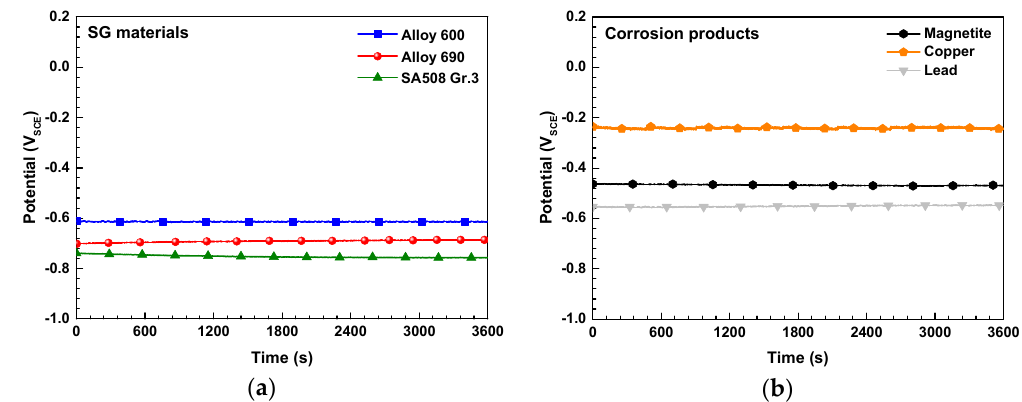
Figure 6. Corrosion potentials of the SG materials and the corrosion products constituting the SG flakes in alkaline solution at 80 °C: ( a ) the SG materials and ( b ) the corrosion products.